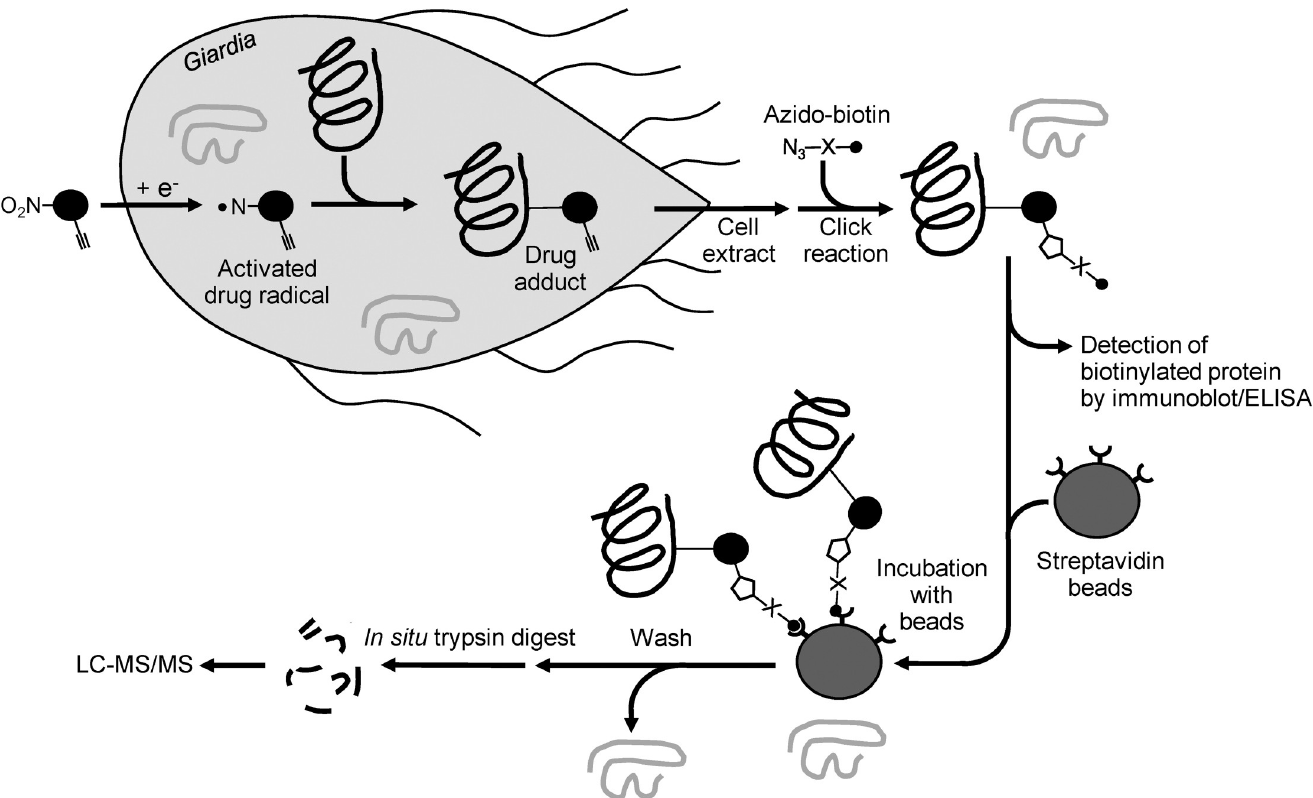
Fig 1. Strategy for identifying adduction targets of nitro drugs by click chemistry. An alkyne labeled 5-NI compound enters trophozoites as an inactive prodrug and is reduced to reactive intermediates, which form covalently linked adducts with multiple target molecules. Cell extracts are prepared and reacted with azido- biotin by the click reaction. The adducted and now biotin-labeled molecules can be detected by immunoblotting or ELISA, or can be isolated by streptavidin-affinity purification. Purified proteins are digested in situ with trypsin, and the resulting peptides are analyzed by LC-MS/MS.